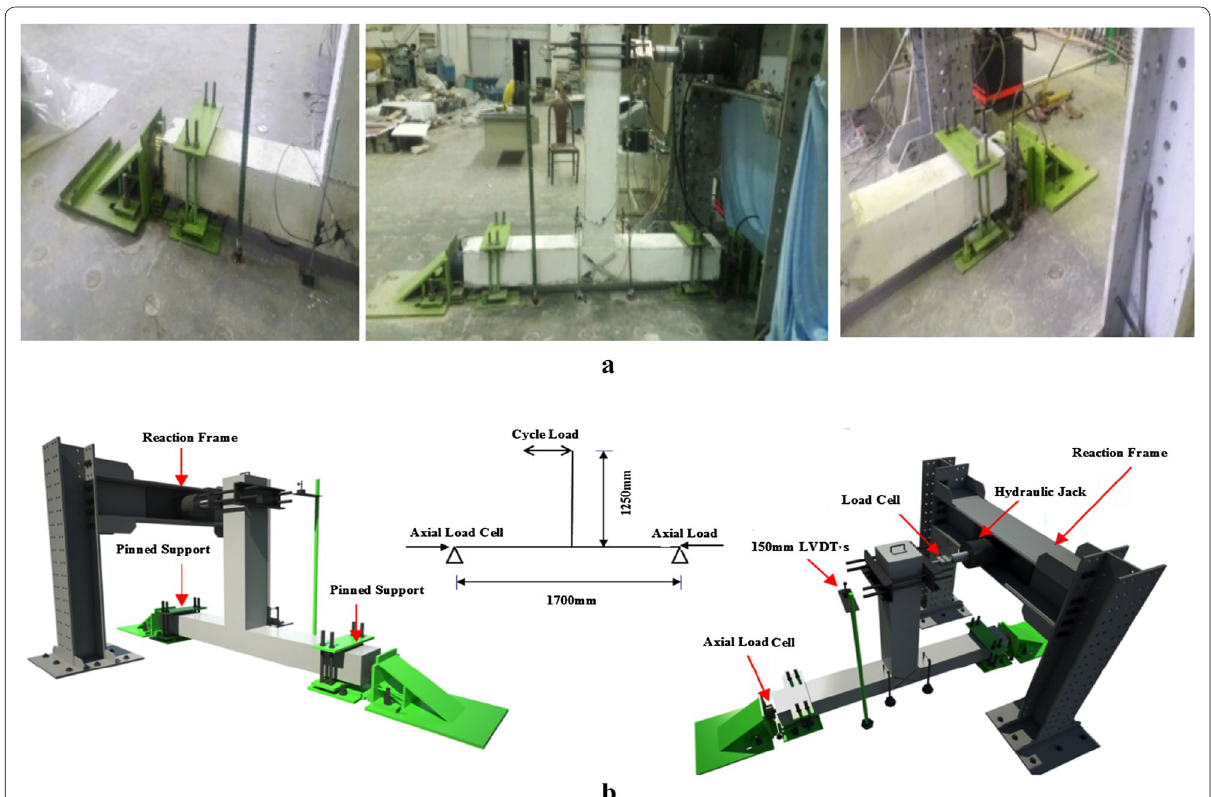
Fig. 12 Test setup and specimen support conditions: a view of test setup; b schematic drawing of the test setup.